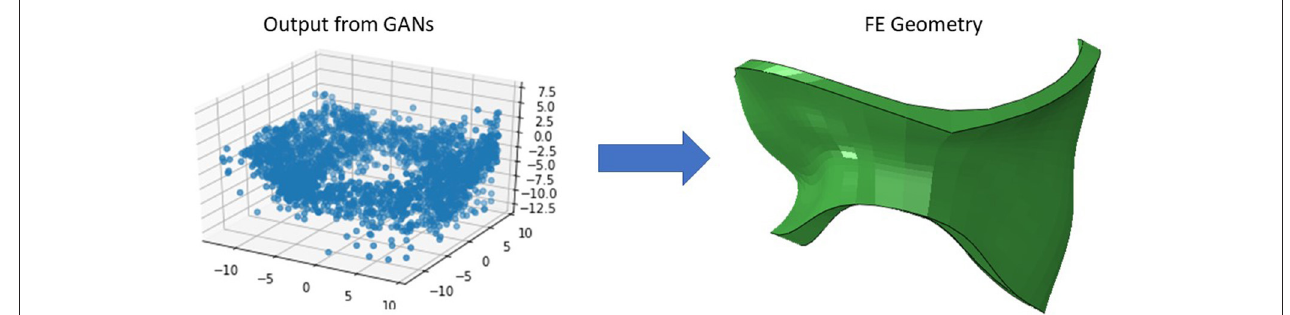
FIGURE 6 | The GAN-generated geometries became more similar to real MVs after several epochs.